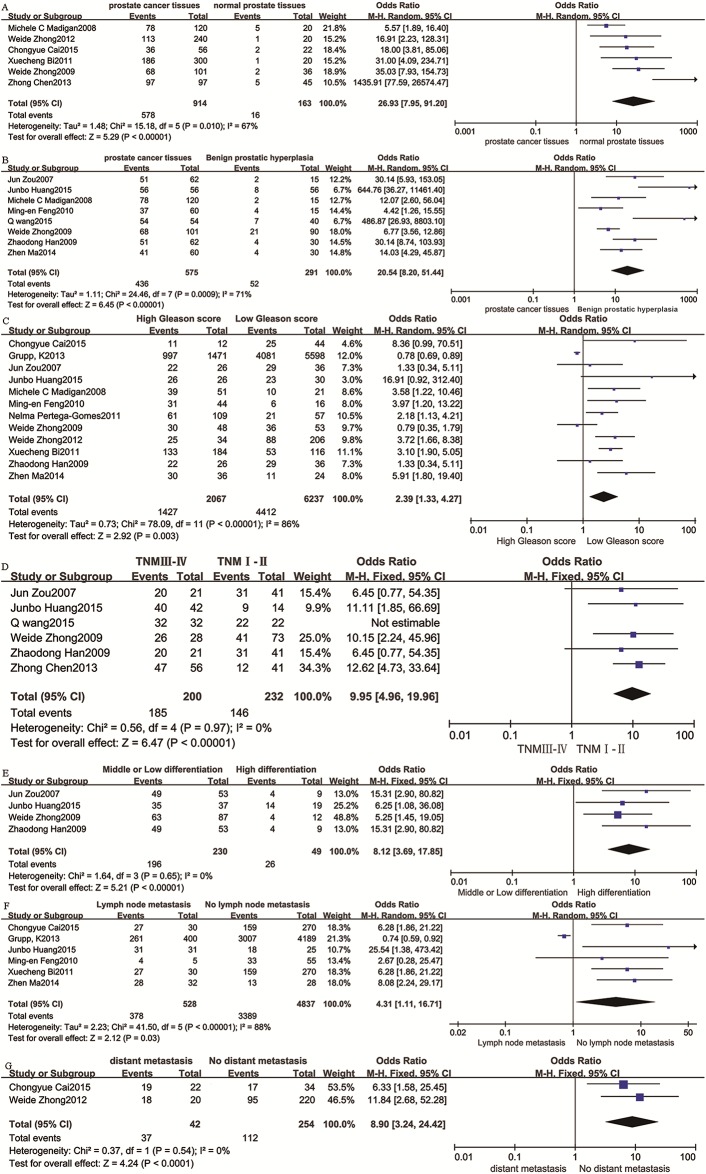
Forest plot of OR was assessed for association between CD147 and clinical pathologic features.A Forest of CD147 expression in prostatic cancer tissues vs normal prostate tissues.CD147 expression was higher in prostatic cancer than normal prostate tissues(OR = 26.93,95%CI = (7.95,91.20),P<0.00001).B Forest of CD147 expression in prostatic cancer tissues vs benign prostatic hyperpiasia tissues.CD147 expression was higher in prostatic cancer than benign prostatic hyperpiasia tissues(OR = 20.54,95% = (8.20,51.44),P<0.00001).C Forest of CD147 expression and Gleason score.CD147 expression was associated with Gleason score of prostatic cancer(OR = 2.39,95%CI = (1.33,4.27),P = 0.03).D Forest of CD147 expression and TNM stage.CD147 expression was associated with TNM stage of prostatic cancer(OR = 9.95,95%CI = (4.96,19.96),P<0.00001).E Forest of CD147 expression and tumor differentiation.CD147 expression was associated with tumor differentiation of prostatic cancer(OR = 8.12,95%VI = (3,69,17.85),P<0.00001).F Forest of CD147 expression and lymph node metastasis.CD147 expression was associated with lymph node metaatasis of prostatic cancer(OR = 4.31,95%CI = (1.11,16.71),P = 0.03).G Forest of CD147 expression and diatal metastasis.CD147 expression was associated with diatal metastasis of prostatic cancer(OR = 8.90,95%CI = (3.24,24.42),P<0.00001).